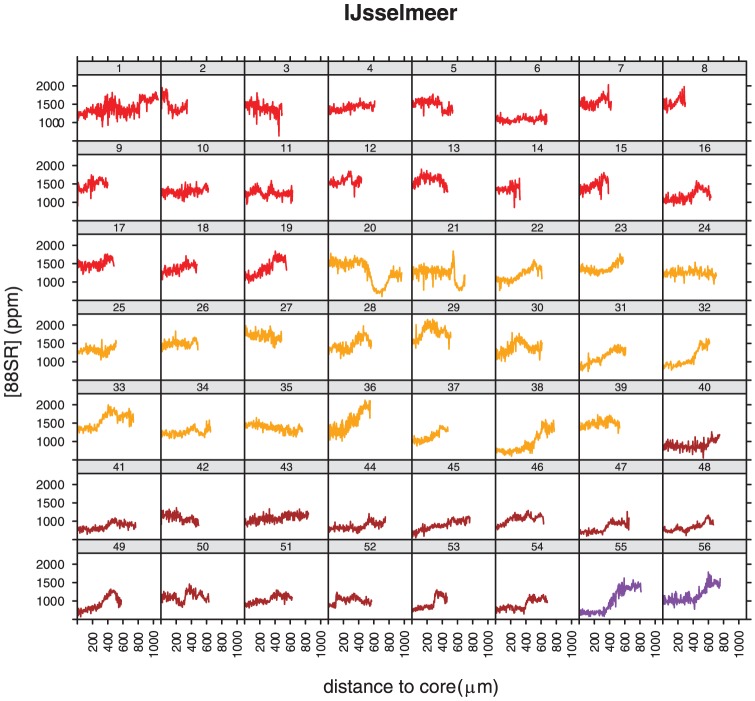
Strontium concentration profiles (in ppm) for smelt caught in Lake IJsselmeer, going from the nucleus (left) to the outer edge (right).The colours indicate the different hauls, all profiles in one colour originate from the same haul.